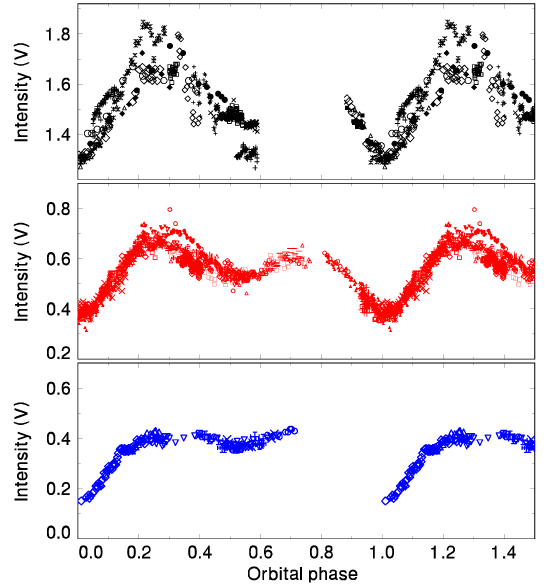
Figure 4: Photoelectric and CCD observations of V Sge from Fig. 3, now sorted into three groups accord- ing to their mean intensity (the orbital ephemeris of Smak 1995). The individual curves of each group were shifted in intensity to match the template. The scale of the ordinate is identical for all three plots. Adapted from ˇSimon et al.